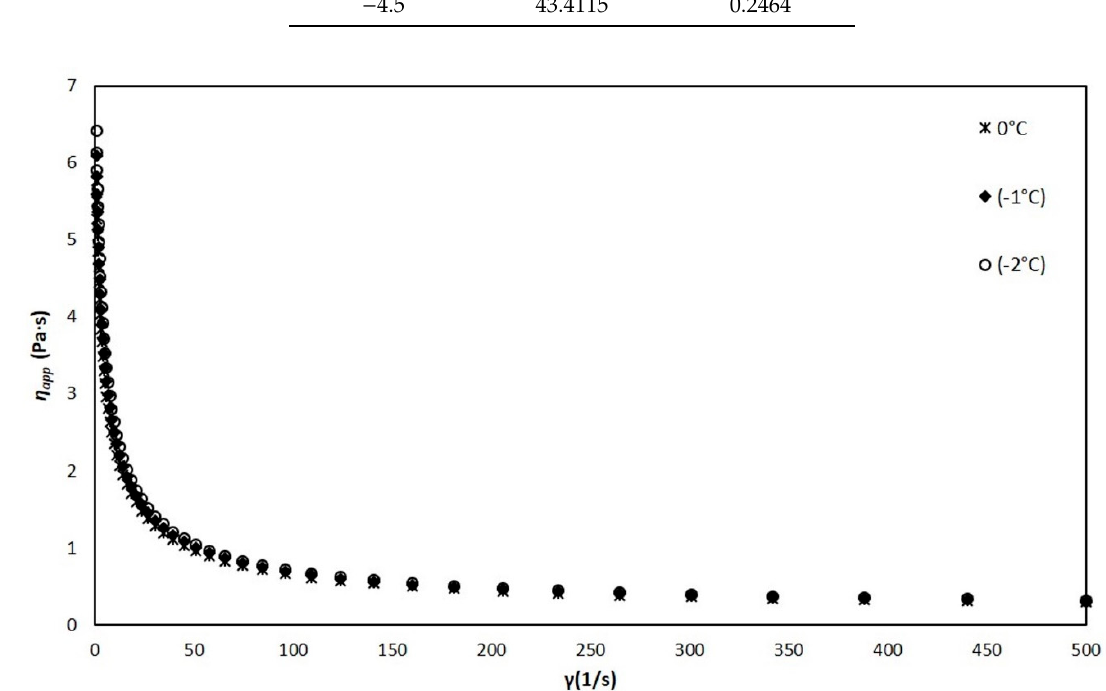
Figure 6. Viscosity of the liquid mixture vs. shear rate at temperatures of 0, − 1, − 2 °C.